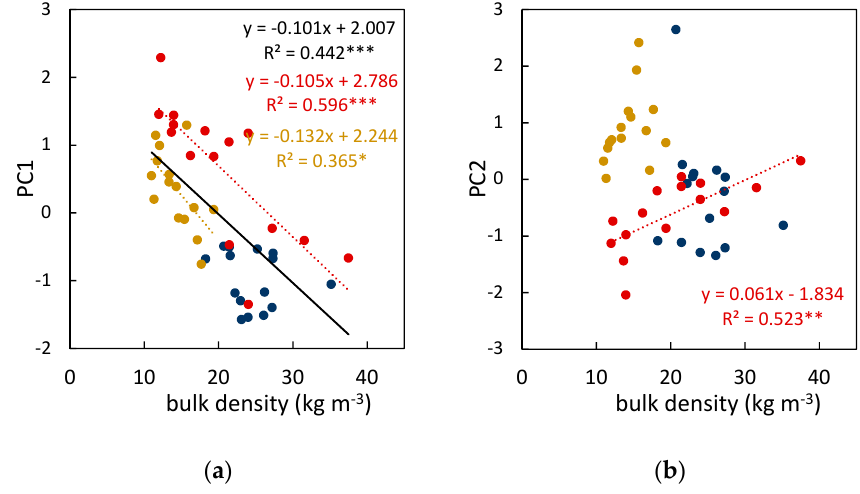
Figure 3. Pairwise regression analyses between: ( a ) bulk density and score to the first principal component (PC1), ( b ) bulk density and score to the second principal component (PC2). For each pair of variables, the analyses were conducted on the whole data set (black regression line and equation), and separately for each species. All provided information is consistently color coded: red corresponding to Aleppo pine ( Pinus halepensis Mill.), blue to carob ( Ceratonia siliqua L.), and yellow to downy oak ( Quercus pubescens Willd.). Regression line, regression equation and significance level are only shown if the relationship was significant. *P ≤ 0.05, **P ≤ 0.01, and ***P ≤ 0.001.